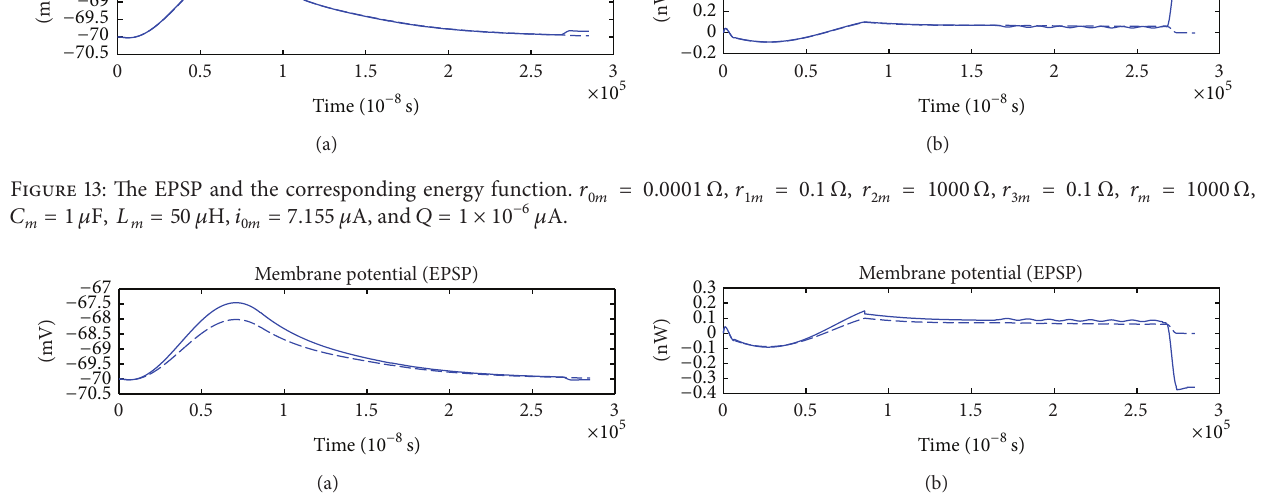
Figure 14: The EPSP and the corresponding energy function. 𝑟 0𝑚 = 0.0001 Ω , 𝑟 1𝑚 = 0.1 Ω , 𝑟 2𝑚 = 1000 Ω , 𝑟 3𝑚 = 0.1 Ω , 𝑟 𝑚 = 1000 Ω , = 1 𝜇 F, 𝐿 = 50 𝜇 H, 𝑖 = 7.155 𝜇 A, and 𝑄 = 2 × 10 −6 𝜇 𝐶 𝑚 𝑚 0𝑚